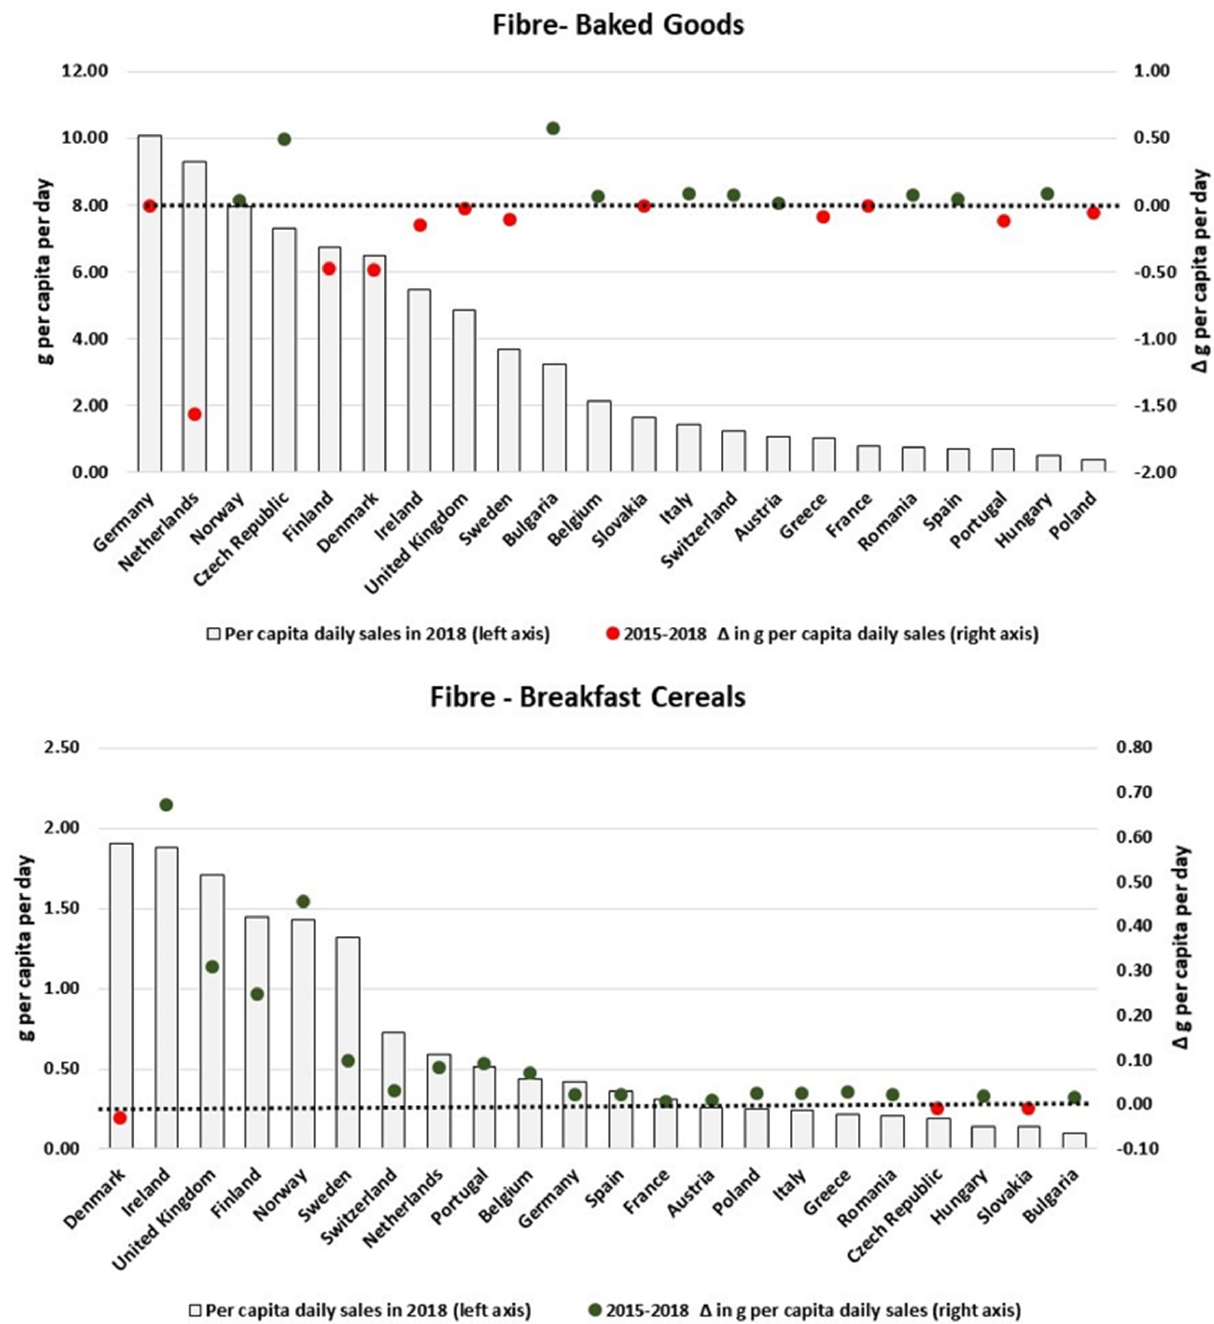
Figure 9. Estimates of fibre sold through Baked Goods and Breakfast Cereals in 2018 and the respective 2015–2018 variation (in g/pc/day). Source: Elaborated by the authors based on data from Euromonitor (2020) and mid-year population estimates from the HFA-DB. Estimates were scaled by market coverage to represent 100% of the retail market. The right-hand axis represents the nutrient variation in g per capita per day (green for positive values, red for negative values), and the dotted black line indicates the variation of 0 g per capita per day as a reference.